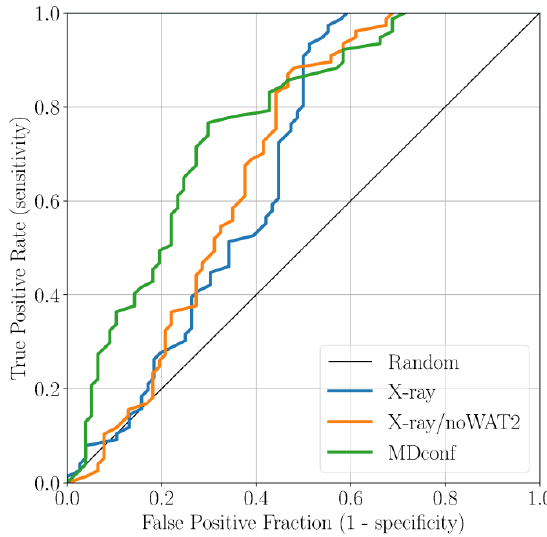
Figure 5. ROC curve for the docking results based on the three receptor structures studied.